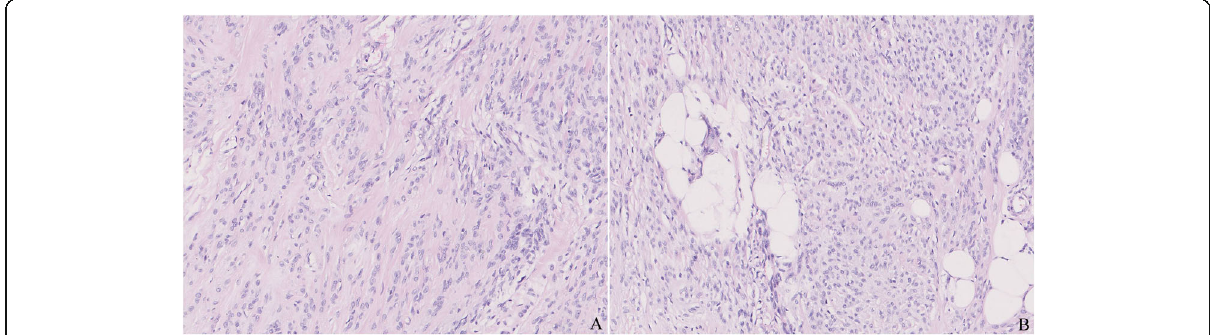
Fig. 2 a . The mass was predominately composed of bland spindle cells with absence of mitoses and necrosis. b . A few islands of mature adipocytes admixed in the